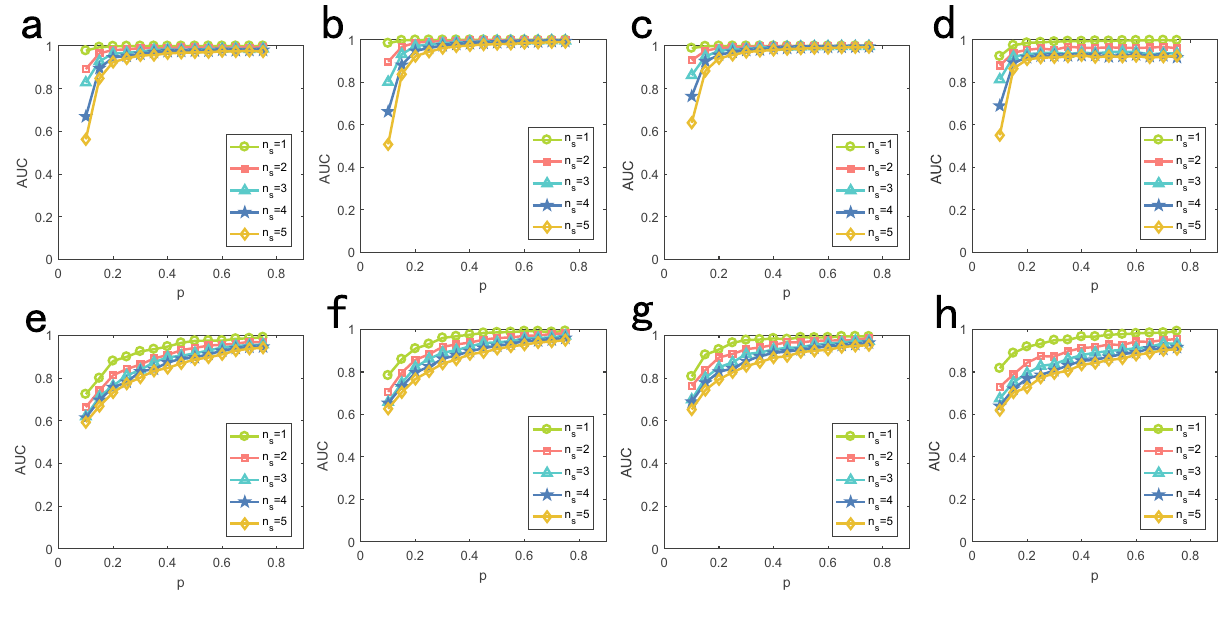
Figure 4. Performance of the multiple source location with different number of sources on model and real networks. We set the number of sources from 1 to 5 and different numbers corresponding to different color. All initial time of sources are set as 0. Abscissa is fraction of observer noddes and ordinate is AUC value. ( a )–( d ) Diffusion dynamics on BA, ER, Football and Santa Fe respectively. ( e )–( h ) are SI dynamics.